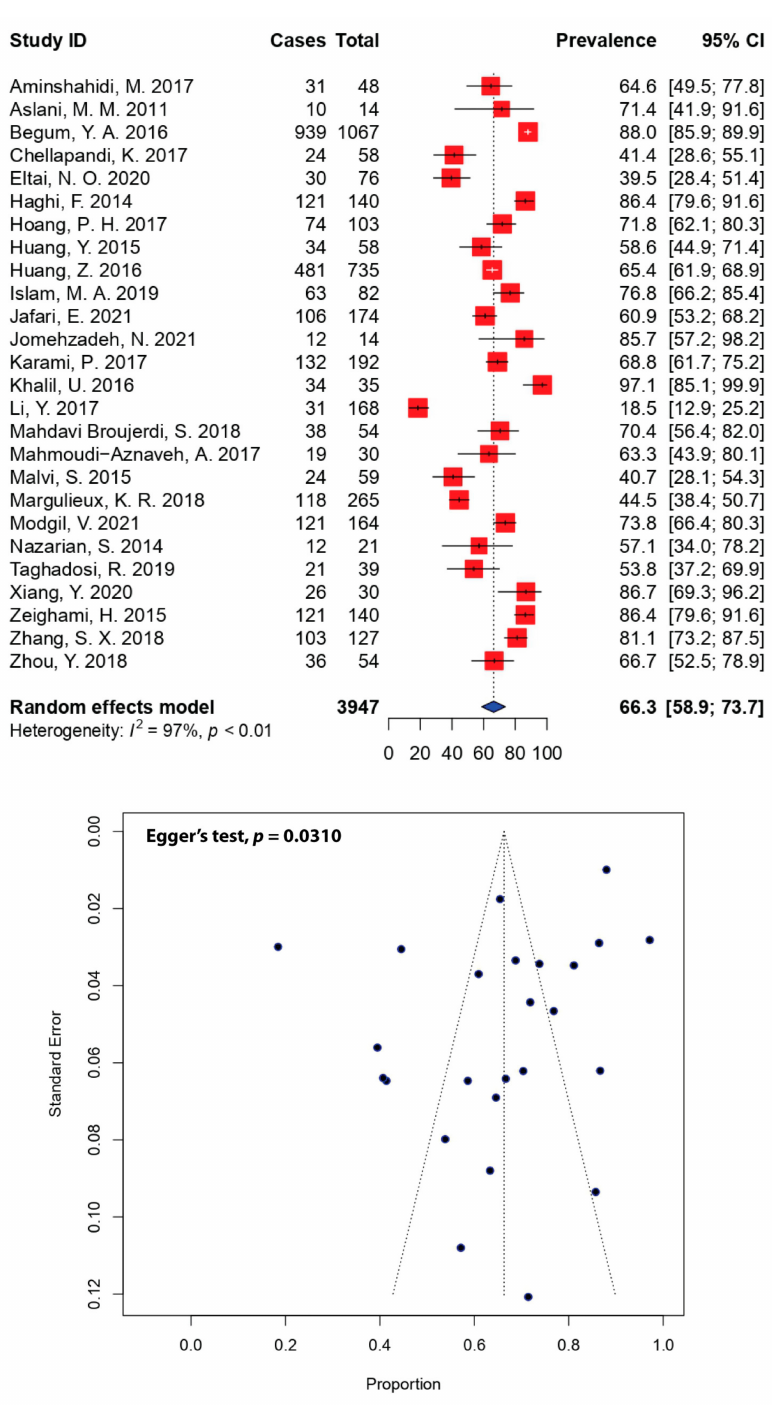
Figure 4. Forest and funnel plots representing the pooled prevalence of multidrug-resistant DEC in Asia. The estimate of prevalence was calculated by pooling 26 selected studies using the random- effects model (top panel). The distribution of effect estimates is shown by a funnel plot (bottom panel). Figures were generated using R